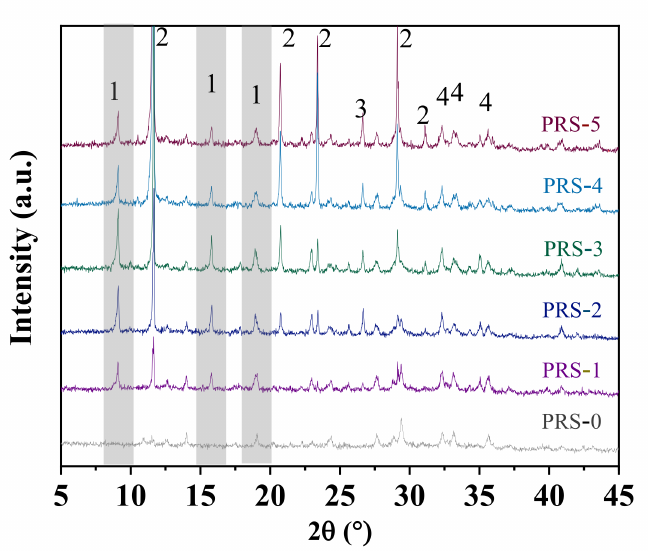
Figure 13. XRD patterns of the composite cementitious material at 28 days with different phospho- gypsum contents (1: ettringite; 2: calcium sulfate dihydrate; 3: SiO 2 ; 4: